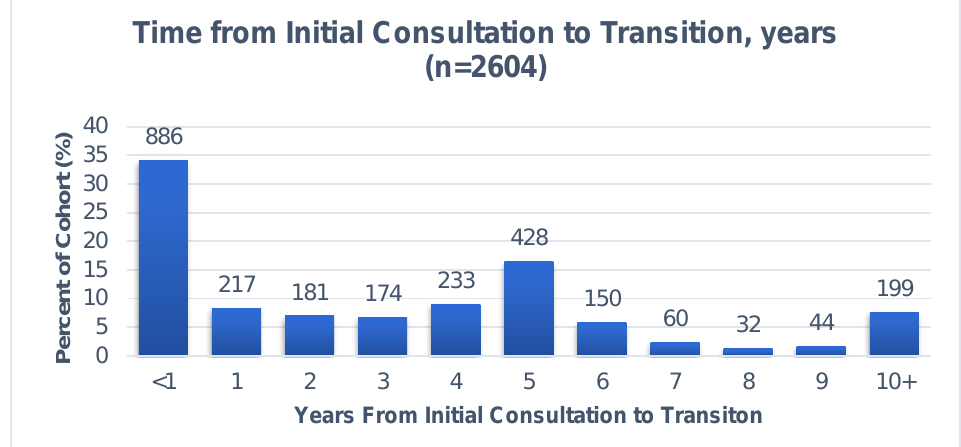
Figure 1. Time from initial consultation to transition, years.